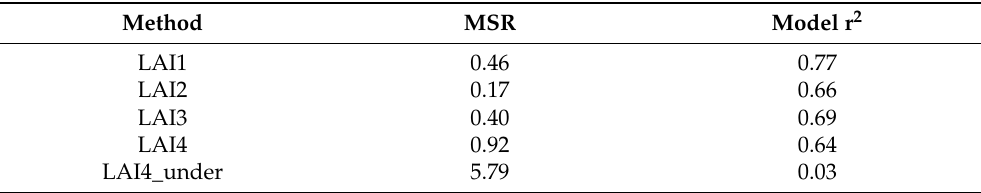
Table 4. Performance metrics for random forests models of LAI based on four overstory estimation methods (LAI1, LAI2, LAI3, and LAI4) and one understory method (LAI4_under). Mean of squared residuals (MSR) and model r 2 are based on out-of-bag samples from 500